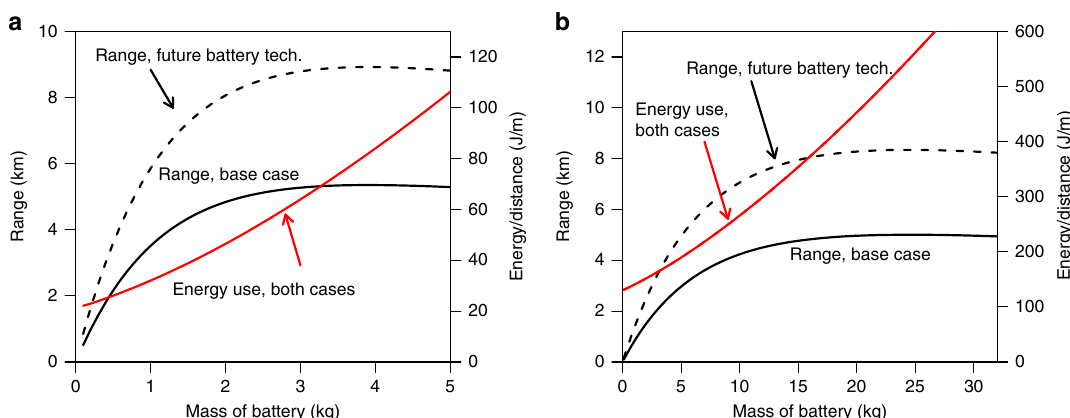
Fig. 2 Range and energy use as a function of battery size for model copters. a Quadcopter results. b Octocopter results. Range (solid black lines) is the sum of a loaded and unloaded trip of the distance shown. The future battery technology (future battery tech.) curves (black dashed lines) re fl ect batteries with higher energy density than currently available (DOE target for 2022 19 ). Red lines show the energy use as a function of battery mass, which is the same for the base case and future battery technology cases. The design battery sizes for the quadcopter and octocopter test models are 0.26 and 4.2